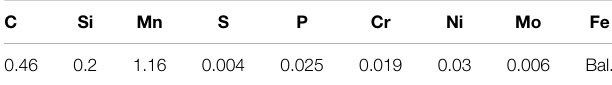
TABLE 1 | Chemical composition of the tested N80 steel ( w /%).